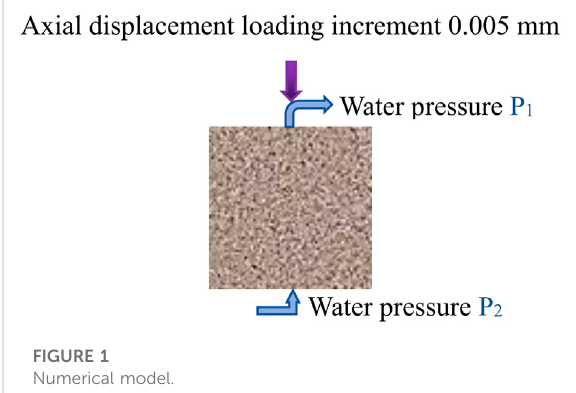
FIGURE 1 Numerical model.